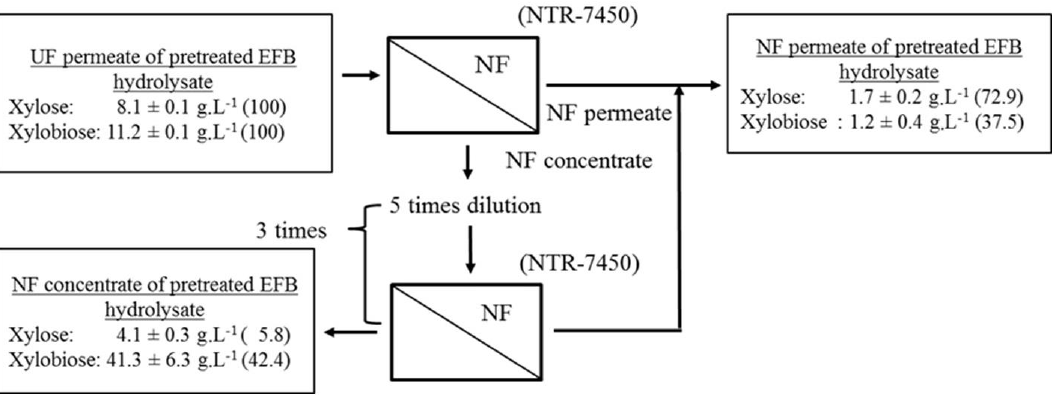
Figure 3. Flow chart showing the distribution of xylose and one of the xylooligosaccharides (XOS), xylobiose. Sugar recovery is shown in the parentheses. Membrane separations using ultrafiltration (UF) and NF were applied to the enzymatic hydrolysate obtained from an alkali-pretreated EFB. Data are presented as the average of the results of triplicate samples.